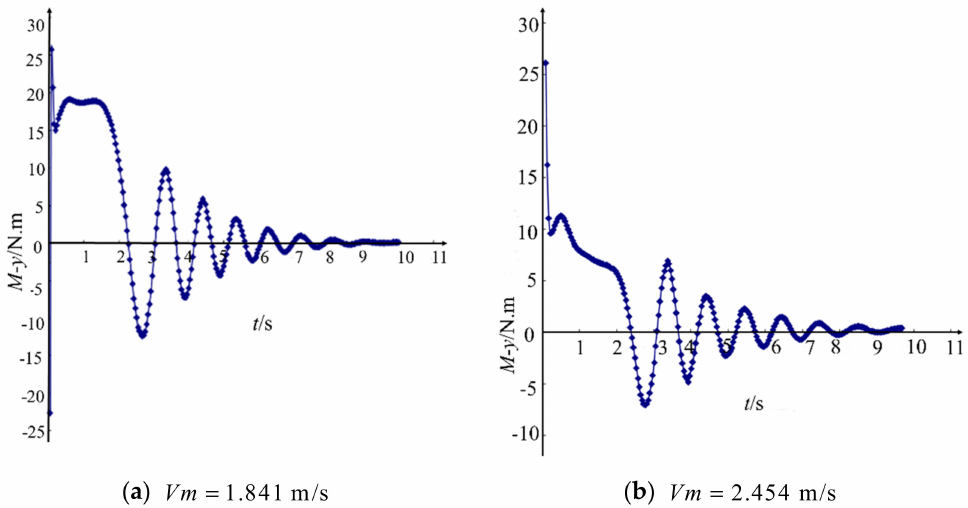
Figure 12. Variation of the torque on the hull with time.